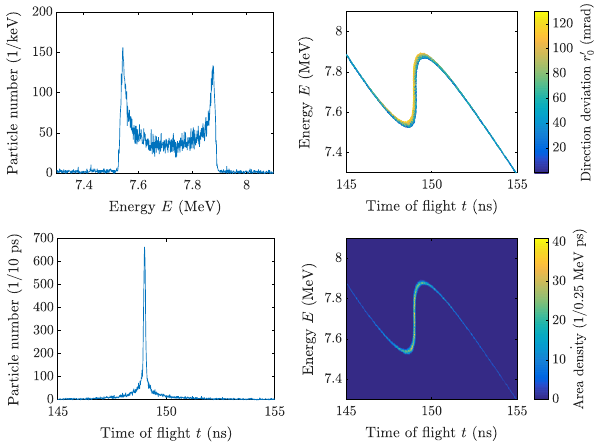
between the energy E , the time of flight t , and the initial direction deviation r 0 0 of the temporally compressed bunch generated by the LIGHT